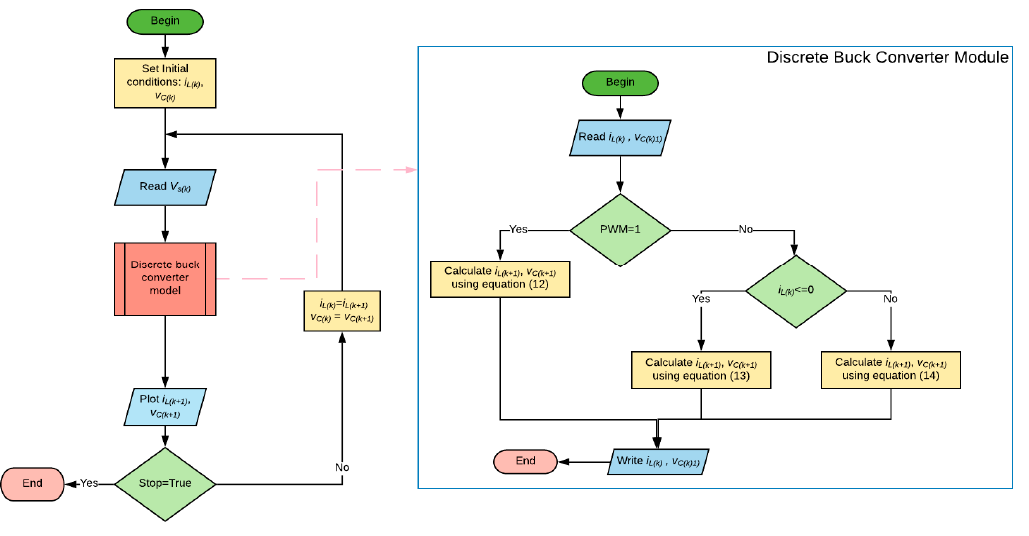
Figure 4. Flow diagram for the implementation of the iterative discrete buck converter model.